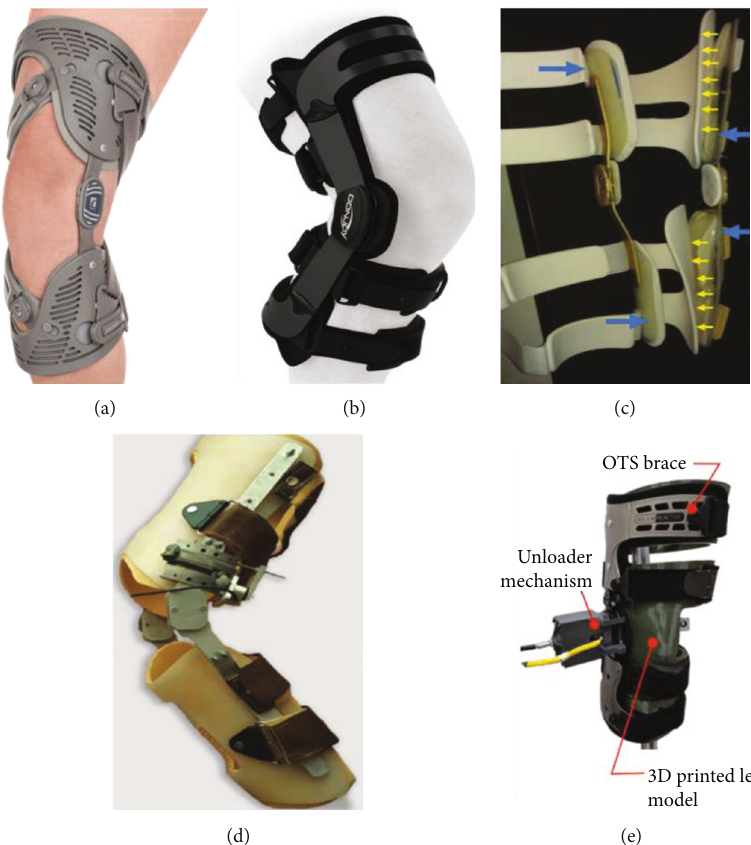
Figure 3: Typical structures of the valgus knee brace. (a) Single-hinged valgus brace (Ossür Unloader One® brace [21]). (b) Double-hinged valgus brace (OA Adjuster brace [22]). (c) Brace with two air cushions [23]. (d) Brace with two degree-of-freedom (DOF) [24]. (e) Brace with control system